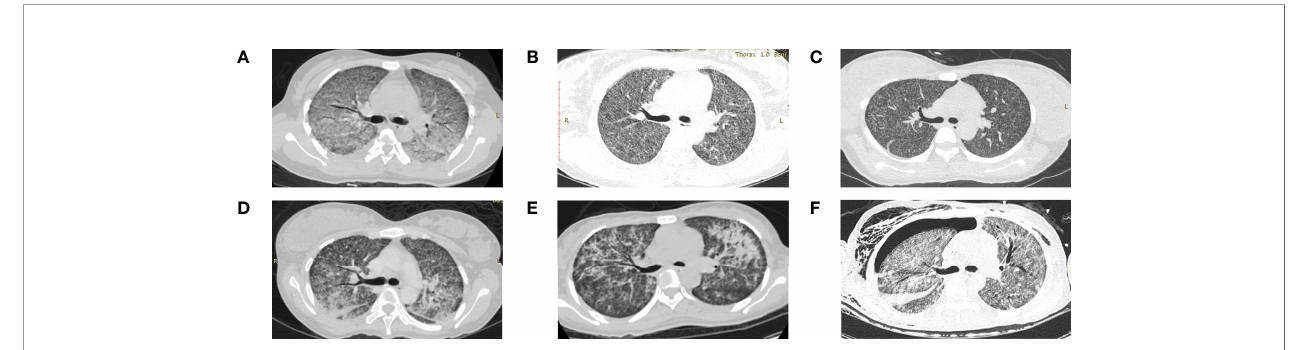
FIGURE 2 | Chest computed tomography scan of six patients from Xiangya Hospital diagnosed with miliary pulmonary tuberculosis after in vitro fertilization and embryo transfer (A) Extensive ground-glass opacity in both lungs. (B) Indiscernible multiple nodules against the background of ground-glass shadows in both lungs. (C) Diffuse random multiple nodules in bilateral lungs. (D) Symmetric distribution of pulmonary in fi ltrate and consolidation in both lungs and bilateral pleural effusion. (E) Multiple patchy high-density shadows in both lungs. (F) Ground-glass opacity, pulmonary in fi ltrate and consolidation in both lungs, and a fl uid pneumothorax at the right